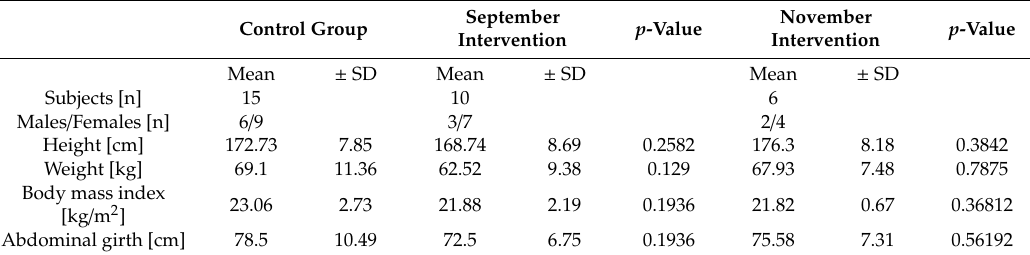
Table 1. Relevant data of the subjects in the control and intervention groups. Values shown are the mean ± standard deviation (SD). A t-test with Welch’s correction was used to compare height and body weight between the groups. A Mann–Whitney test was used to compare body mass index (BMI) and abdominal girth (marked in green). The chi-square test was used for gender analysis. n = number of